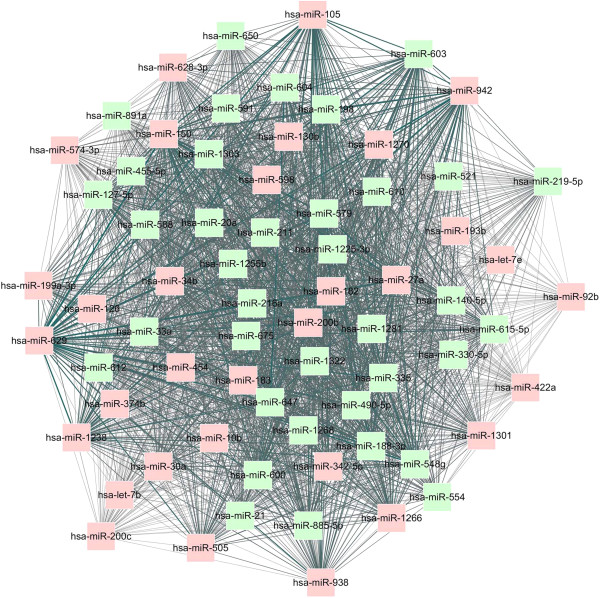
Co-regulating network of differentially expressed miRNAs. Red nodes represent up-regulated miRNAs, green nodes represent down-regulated miRNAs, and edges indicate that there are co-regulating target genes between the two miRNAs.